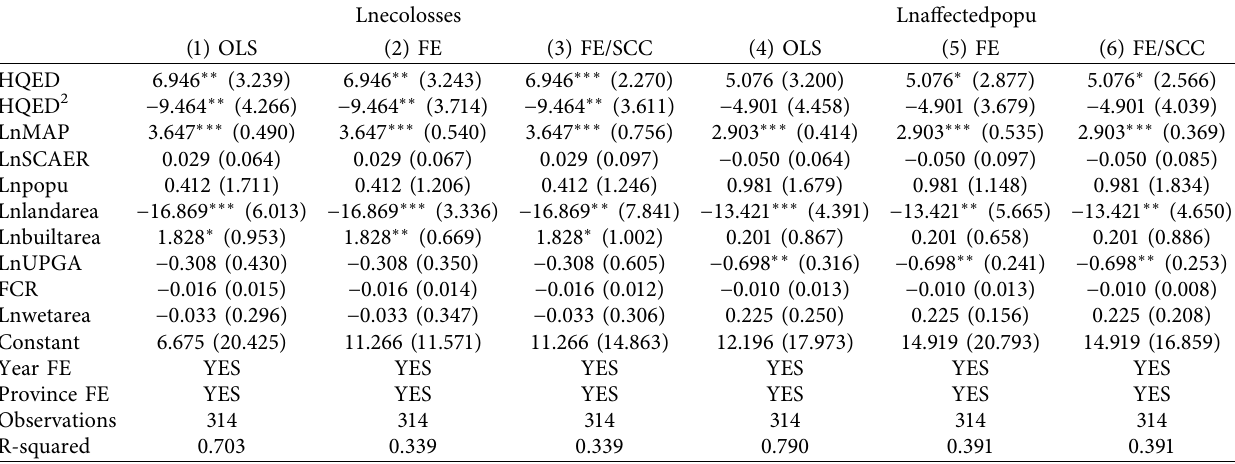
Table 5: Baseline estimation